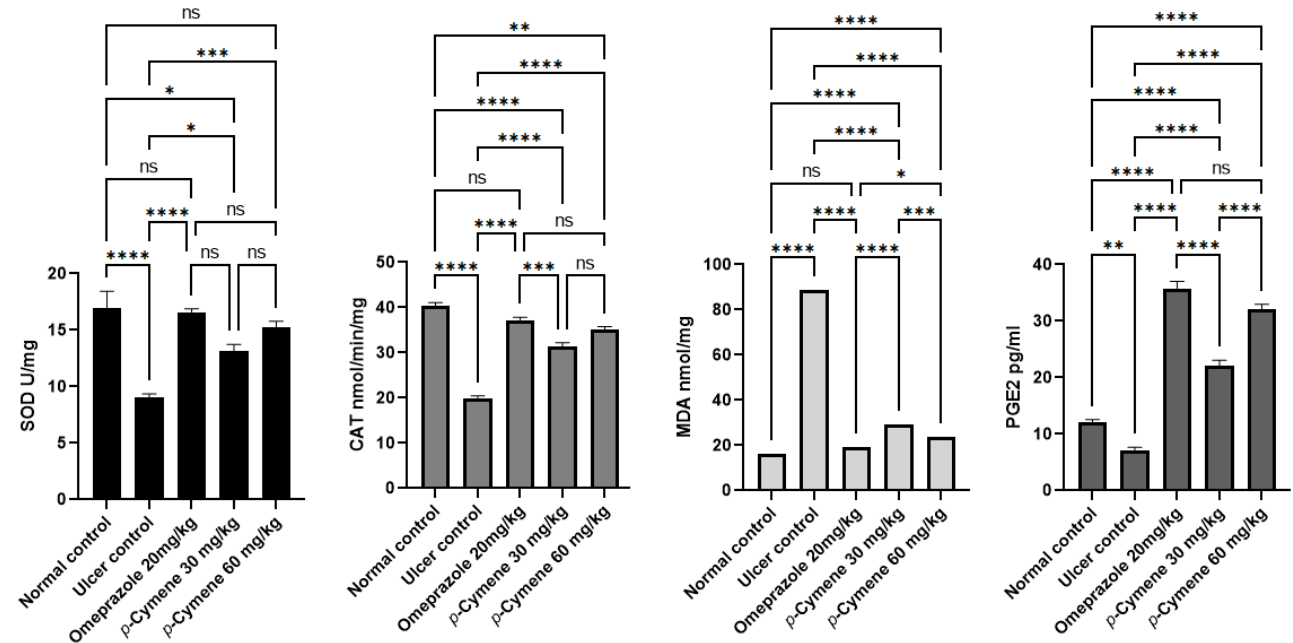
Figure 8. The effect of p -Cymene on PGE2, MDA, CAT, and SOD in ethanol-induced gastric ulcers in rats. Pre-treatment groups: normal control 0.5% CMC (G1), ulcer control 0.5% CMC (G2), omeprazole 20 mg/kg (G3), p -Cymene 30 mg/kg (G4), p -Cymene 60 mg/kg (G5). Values presented as means (n = 6). ns, non-significant; *, p < 0.05; **, p < 0.01; ***, p < 0.001; ****, p < 0.0001.